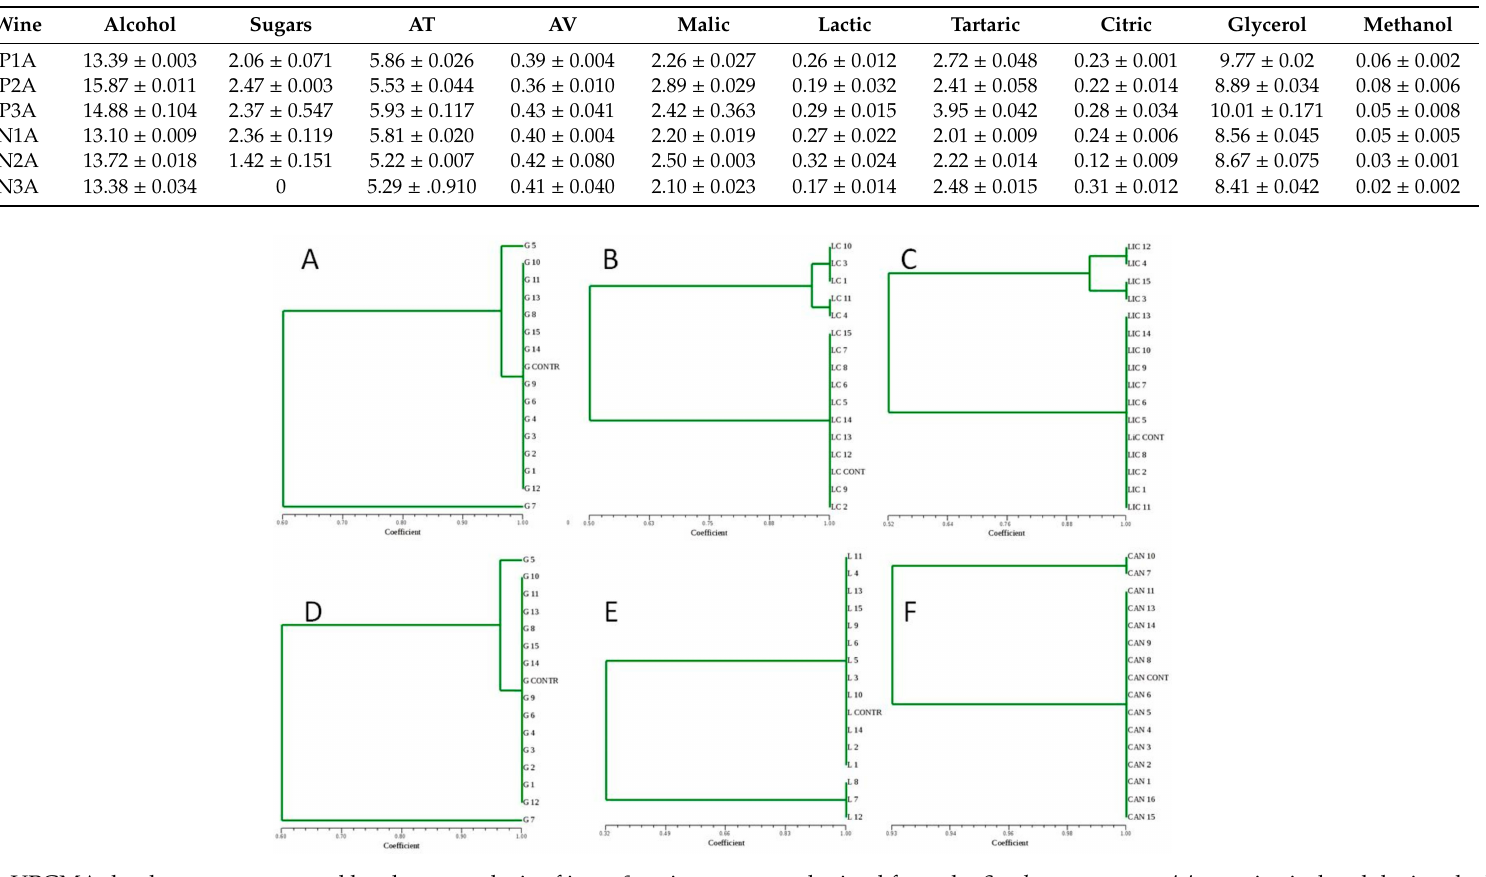
Figure 1. UPGMA dendrograms generated by cluster analysis of inter- δ region patterns obtained from the Saccharomyces cerevisiae strains isolated during the later stages of six di ff erent large-scale vinifications obtained from: Primitivo grape must PA1 ( A ), PA2 ( B ), and PA3( C ) inoculated with the 14093 strain; Negroamaro grape must NA1 ( D ), NA2 ( E ), and NA3( F ) inoculated with the 14077 strain. The genomic DNA extracted from a pure culture of the 14093 and 14077 strains have been used as a control